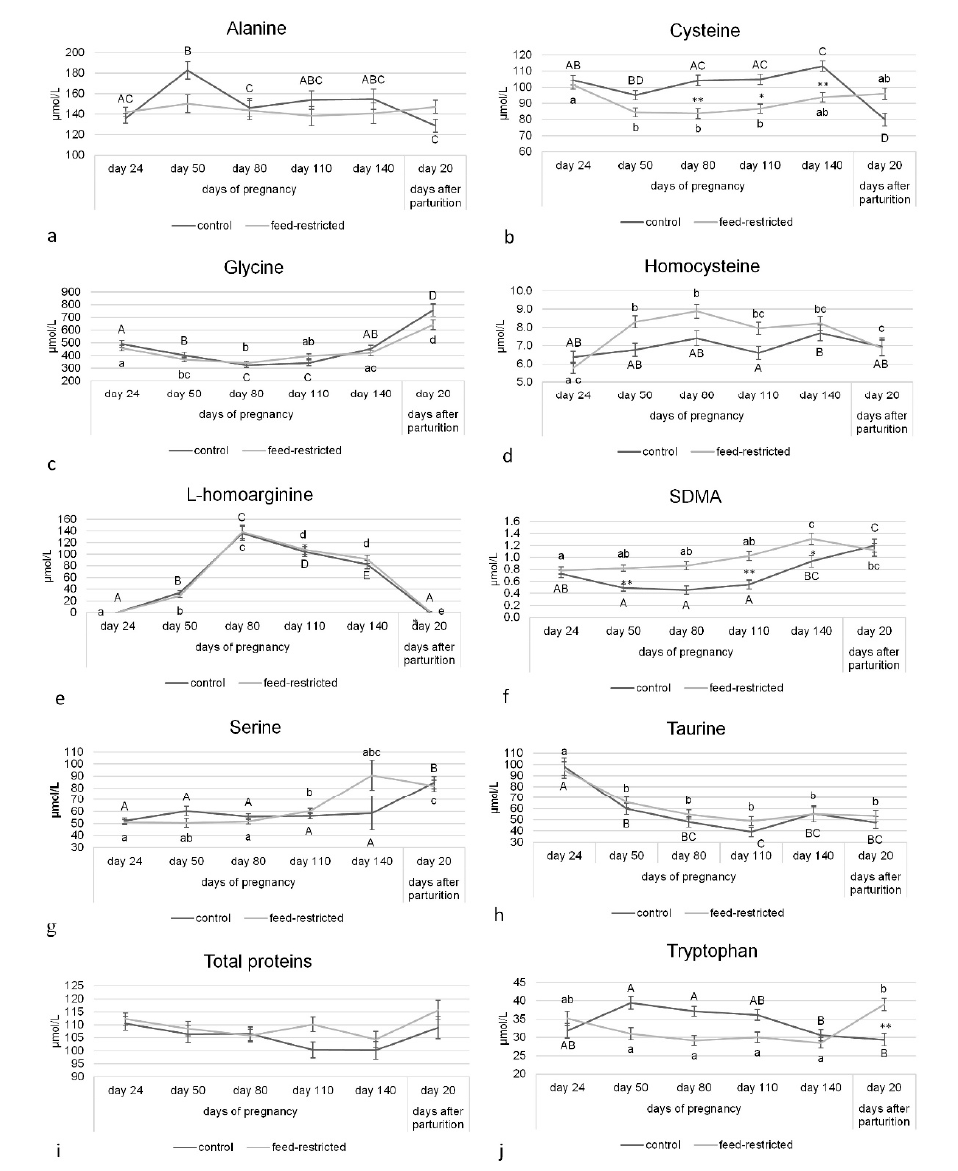
Figure 1. Circulating concentrations of arginine metabolites, other amino acids, and total proteins in control and feed-restricted ewes from day 24 of pregnancy to day 20 after parturition. ( a ) Alanine; ( b ) Cysteine; ( c ) Glycine: ( d ) homocysteine; ( e ) L-homoarginine; ( f ) SDMA; ( g ) serine; ( h ) Taurine; ( i ) Total protein; ( j ) Tryptophan. Asterisks indicate significant di ff erences between control and feed-restricted ewes: ANCOVA * p < 0.05; ** p < 0.01. Di ff erent letters indicate significant di ff erences within the same group: Upper-case letters for control group and lower-case letters for feed-restricted